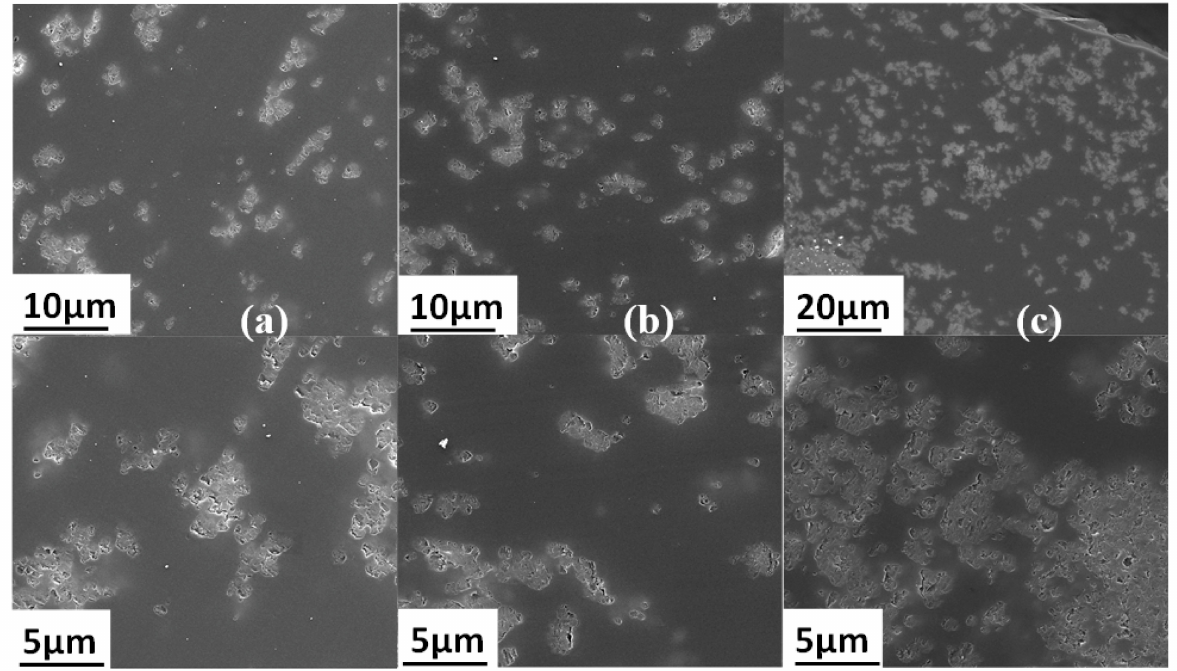
Figure 6. SEM images of ( a ) PEI/10 wt% ZIF-8 ( b ) PEI/15 wt% ZIF-8 and ( c ) PEI/20 wt%